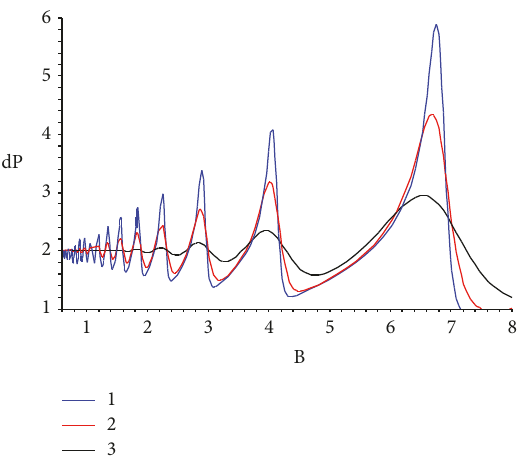
Figure 3: The temperature dependence of microwave-radiation absorption oscillations in semiconductors. 1- T = 3 K; 2- T = 25 K; 3- T = 77 K.